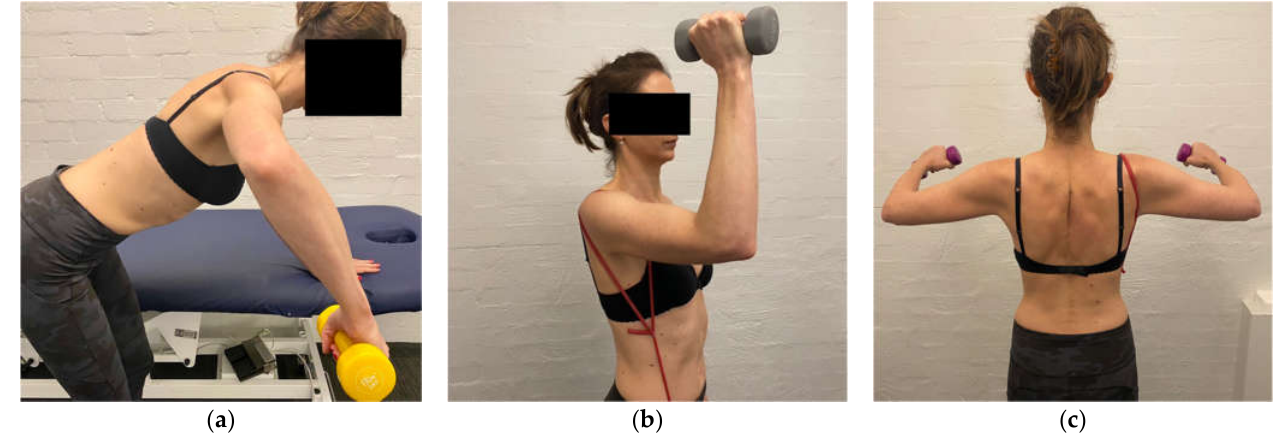
Figure 11. ( a ) Bent-over row at 90° of elevation ( b ) overhead press ( c ) short lever lateral